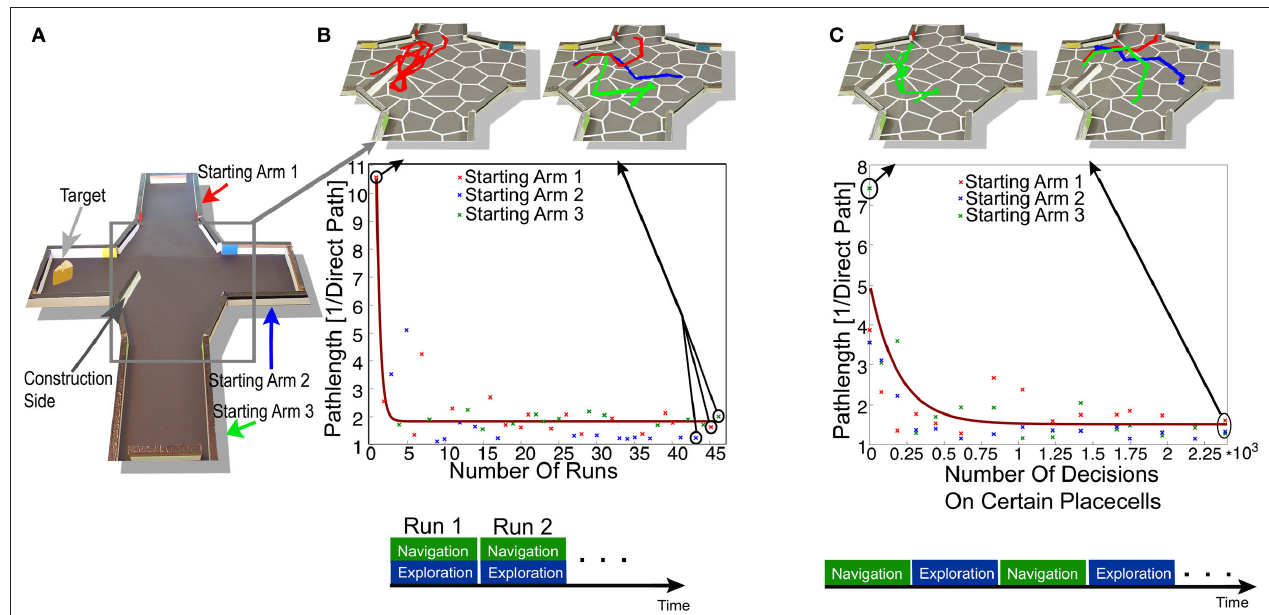
Figure  | (A) A new obstacle (construction side) is added in an already learned environment. To test the adaptation process we evaluated the robots path through the construction side to the target side starting from three different start states, each located in one of the three different arms. (B) The adaptation process was done with online learning. This type of learning corresponds to an Exploration and Navigation stage at the same time, as shown in the lower part of the figure. The pictures in the upper part show the robot’s path in an area around the added obstacle, while the robot navigated to the target. The robot’s path length in this area is plotted in the center of this figure. The different colors